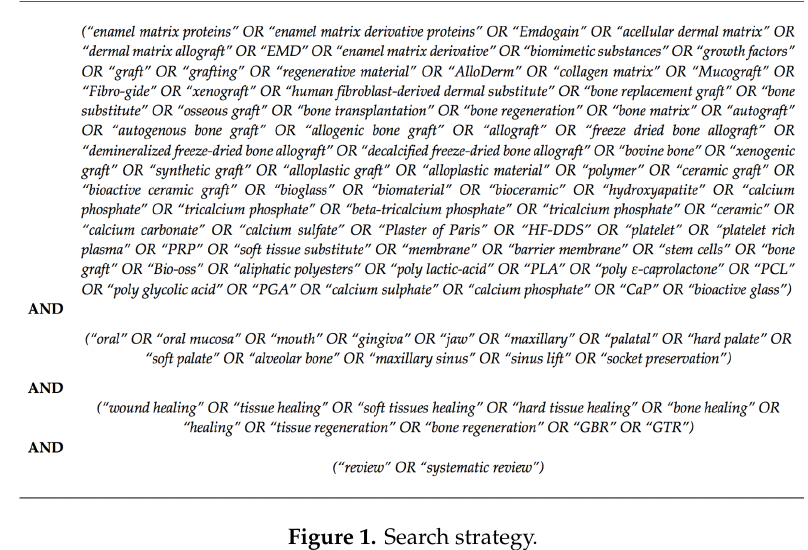
Figure 1. Search strategy.